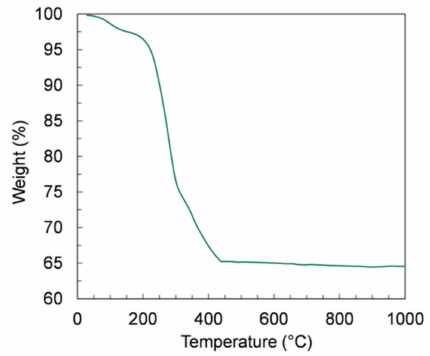
Figure 9. Thermogravimetric analysis (TGA) curve of the green tape prepared using powder D and slurry 4